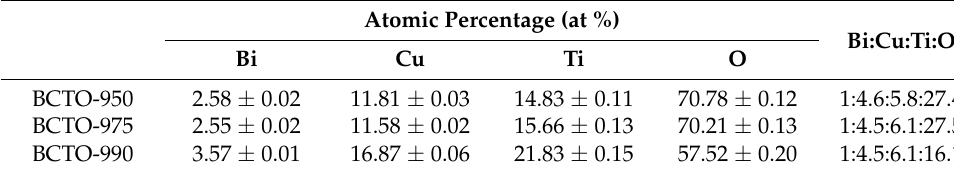
Table 1. EDS quantitative elemental analysis for BCTO ceramic samples.